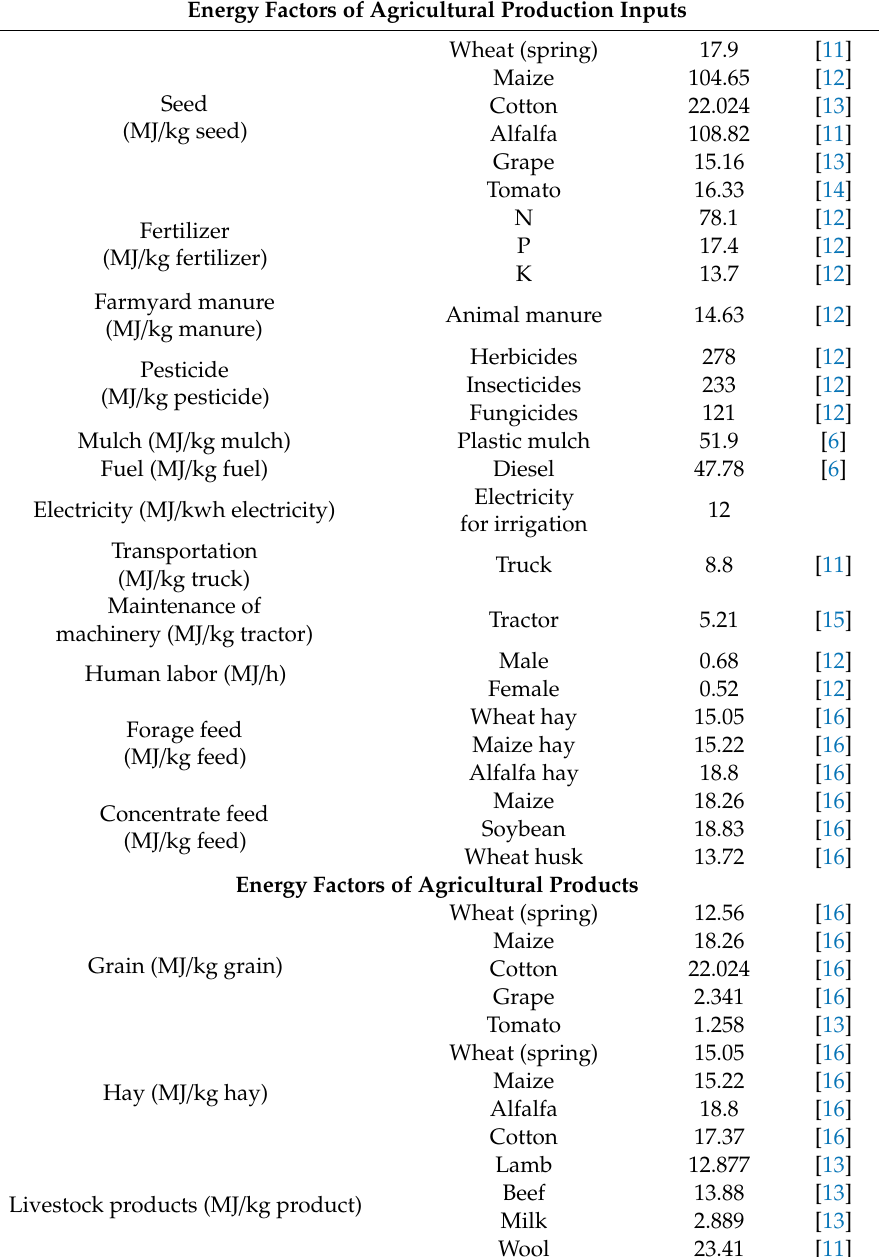
Table 1. Factors used for the calculation of energy inputs and energy